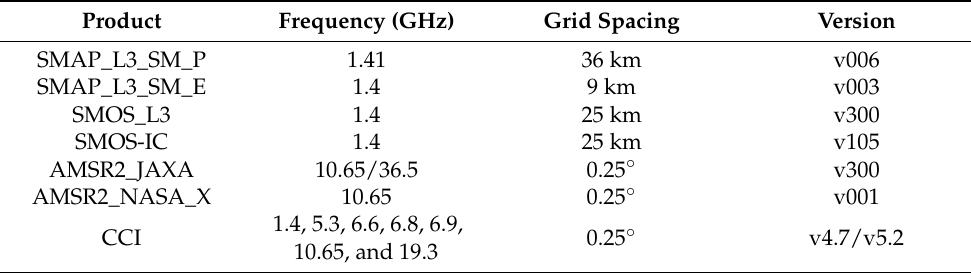
Table 1. The RS (remote sensing) SM (soil moisture) product